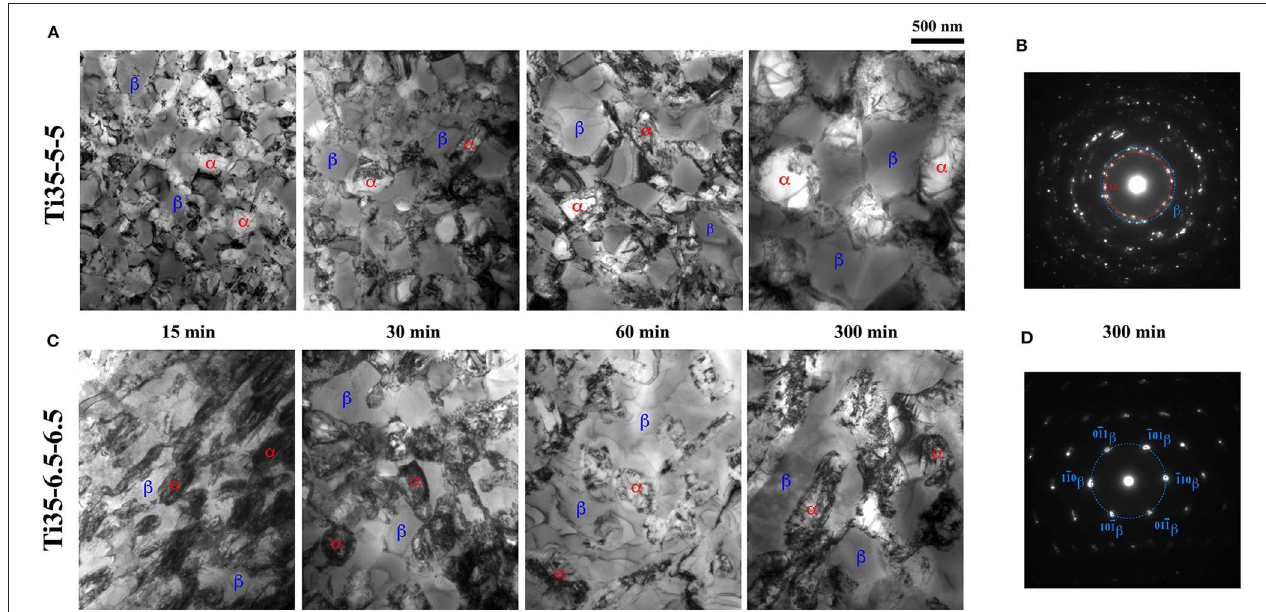
FIGURE 5 | Transmission electron microscopy (TEM) bright-field microstructures after 90% cold rolling and annealing at 650 ◦ C for 15, 30, 60, and 300min of (A) Ti35-5-5 and (B) Ti35-6.5-6.5. Selected area diffraction (SAD) pattern of a 2- µ m-diameter diaphragm after 300min at 650 ◦ C of (C) Ti35-5-5 (D) Ti35-6.5-6.5.